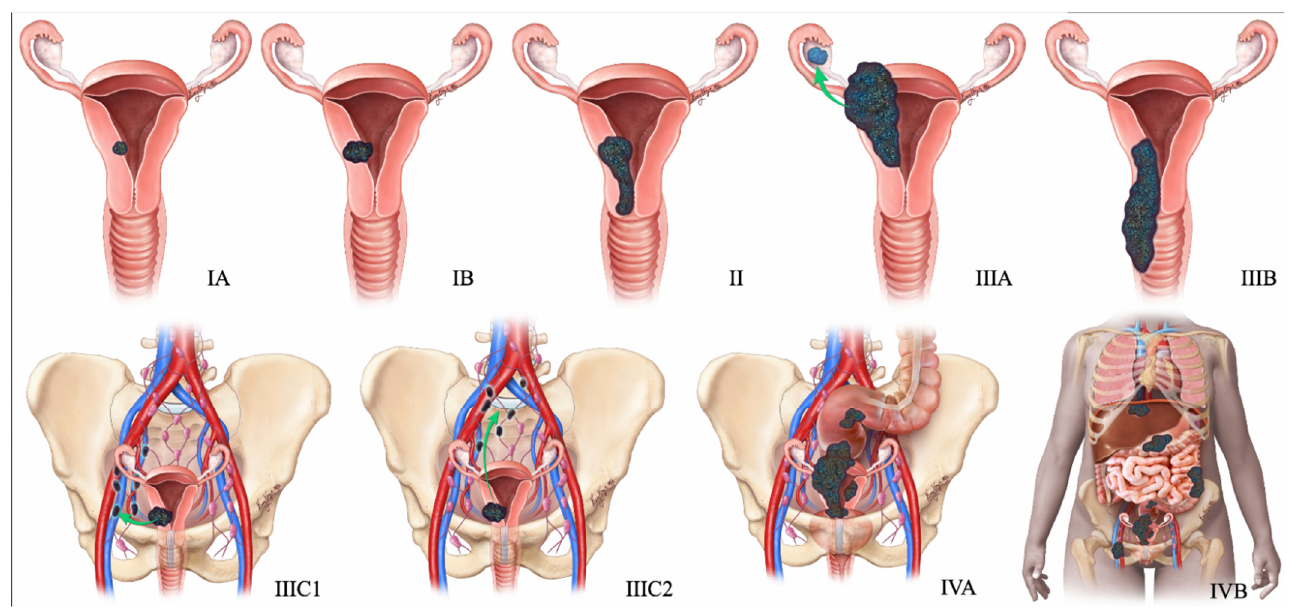
Figure 12. 2009 FIGO staging system for endometrial cancer. Stage I tumor confined to the uterus. Stage IA < 50% myometrial invasion. Stage IB ≥ 50% myometrial invasion. Stage II